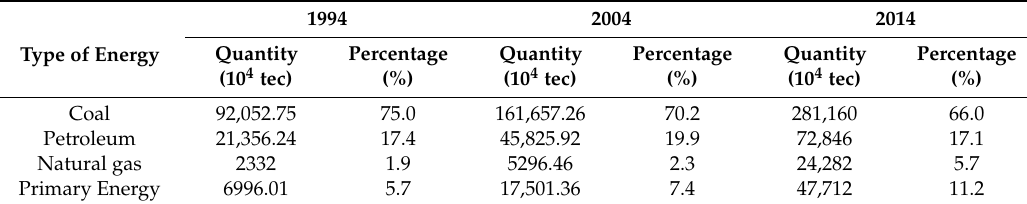
Table 1. Energy consumption structure of China 1